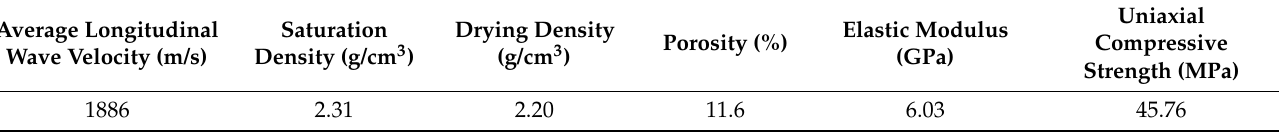
Figure 1. Rock specimens and the defective sample. Table 1. Basic physical parameters of siltstone.